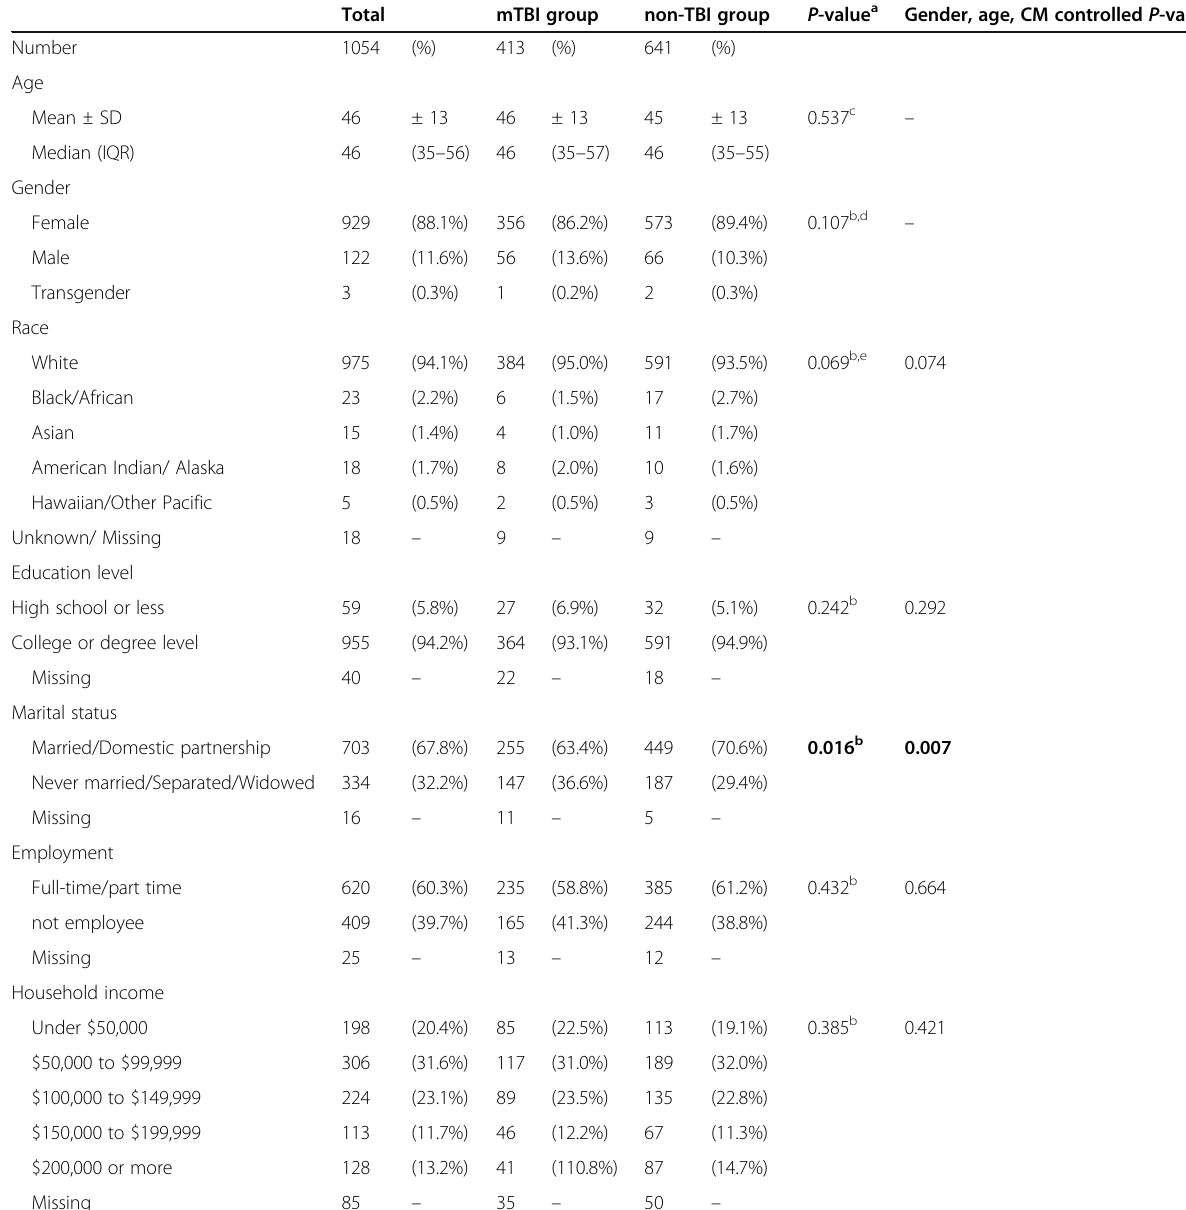
Table 1 Subject sociodemographics and headache diagnoses Total mTBI